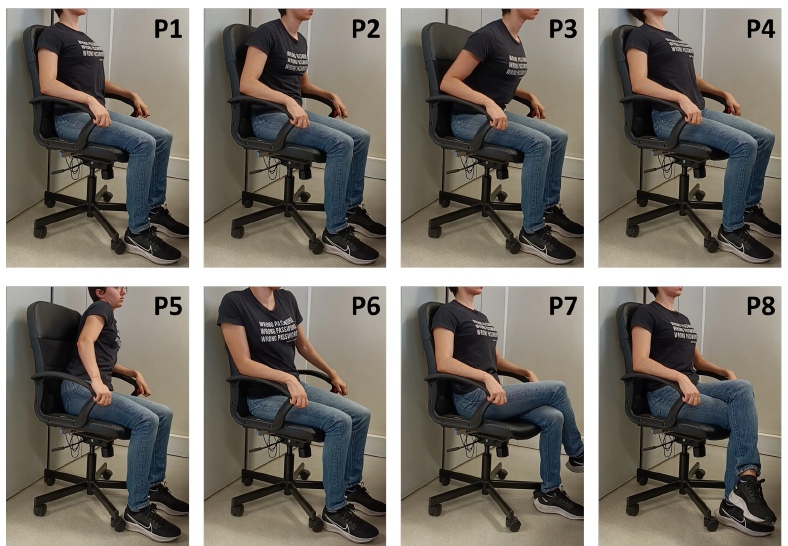
Figure 4. Sitting positions used in the experiments and their respective class label: ( P1 ) Upright sitting; ( P2 ) Slouching; ( P3 ) Leaning forward; ( P4 ) Leaning backward; ( P5 ) Leaning left; ( P6 ) Leaning right; ( P7 ) Right leg crossed; and ( P8 ) Left leg